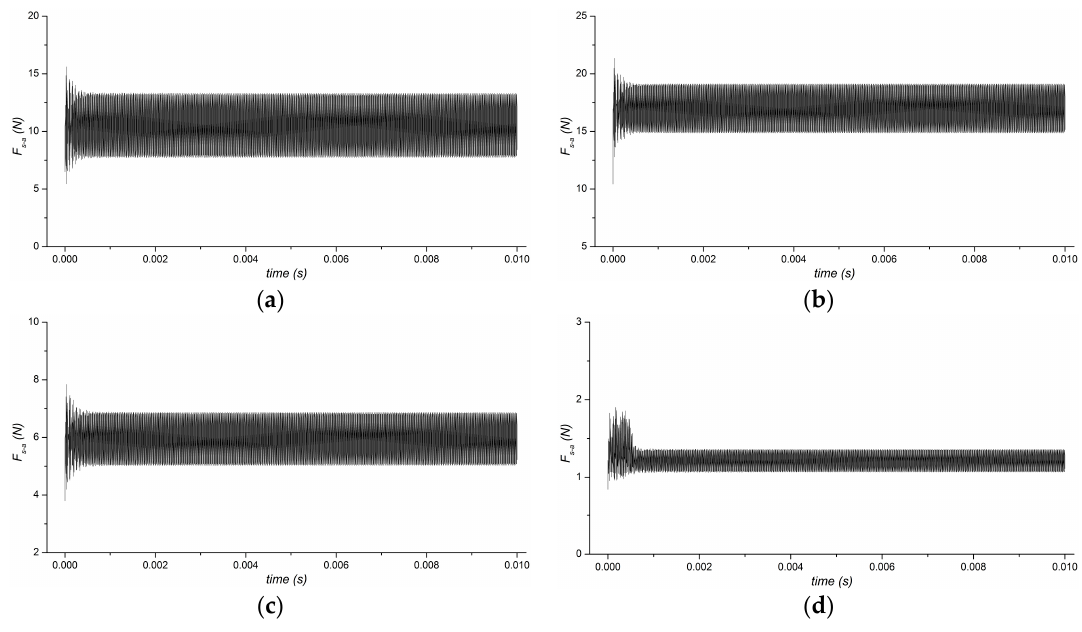
Figure 4. Contact forces in ultrasound loading step at ( a ) 40 °C, ( b ) 110 °C, ( c ) 120 °C, and ( d ) 135